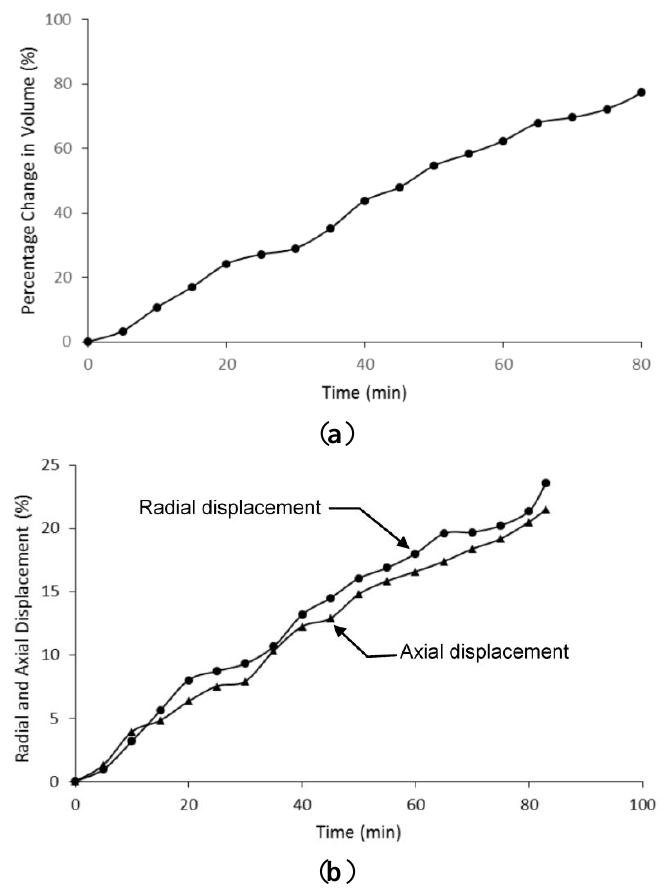
Figure 11. Measured dimensional changes to the HEMA-AA hydrogel actuator embedded in the microchannel as the bR-PAA transducer is exposed to a constant (18 mW, 568 nm) light source. ( a ) Percent change in gel volume over time. ( b ) Percent change in radial and axial displacements of gel over